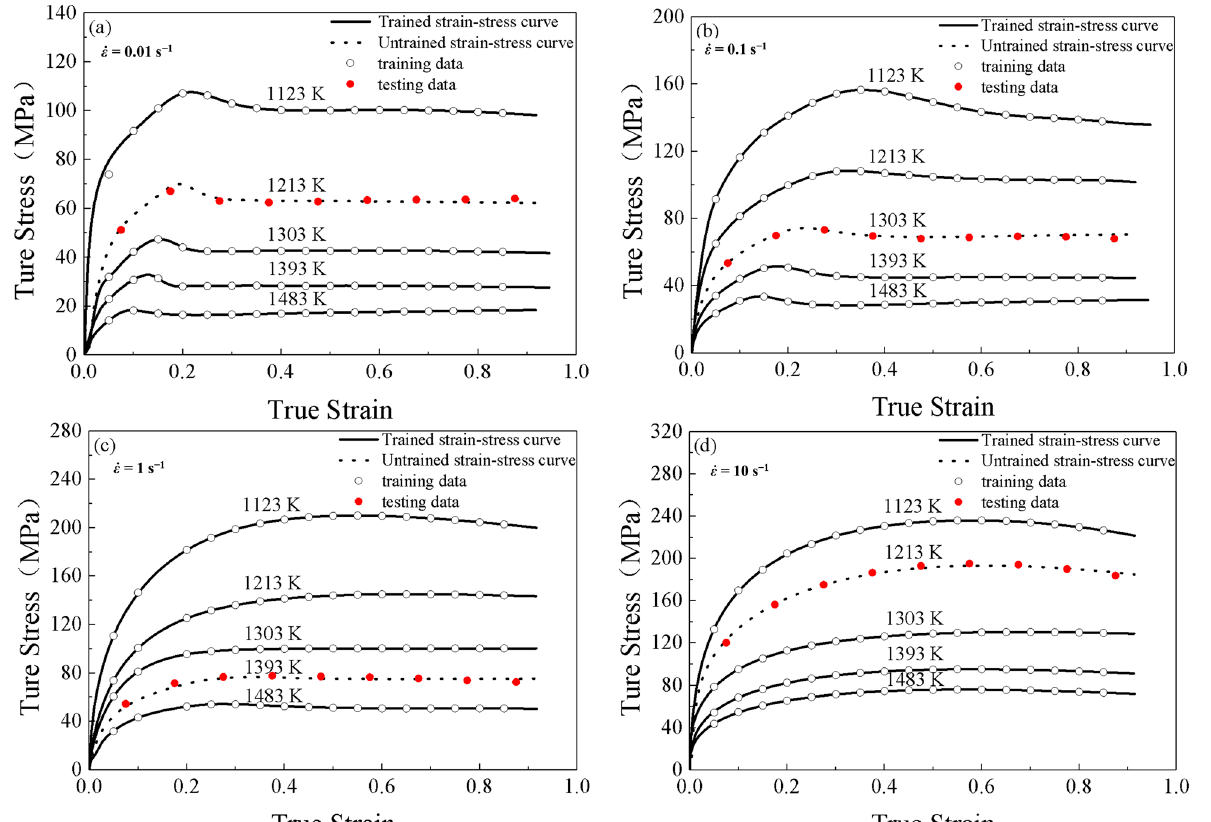
Figure 10. Comparisons between the trained flow stresses and tested flow stresses predicted by the PSO-BP integrated model at different strain rates and temperatures of ( a ) 0.01 s − 1 , ( b ) 0.1 s − 1 , ( c ) 1 s − 1 , and ( d ) 10 s − 1